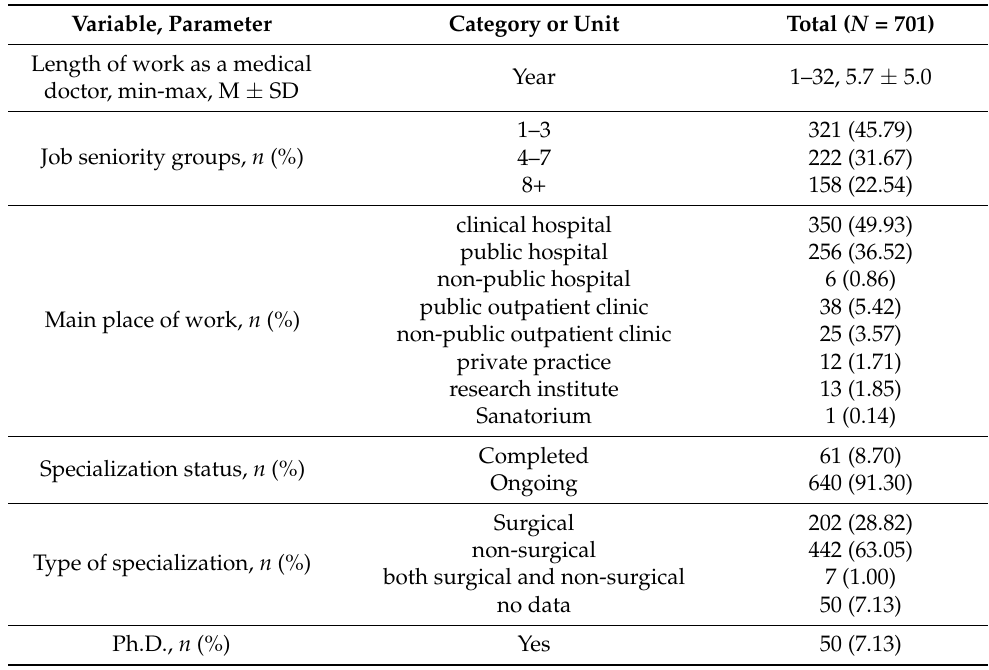
Table 2. Professional characteristics of the study